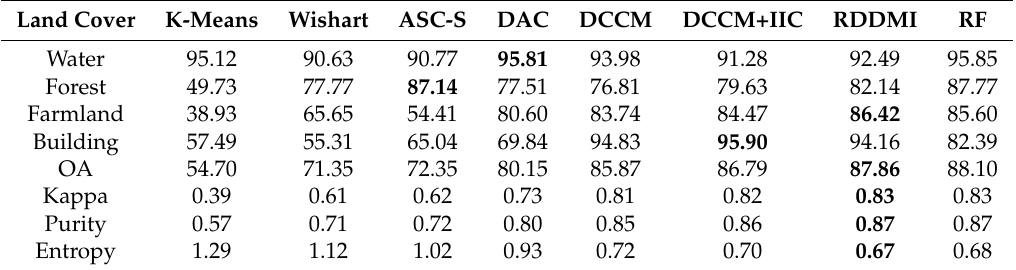
Table 3. Performance evaluation of RS-2 Flevoland classification results. The numbers in bold denote the best unsupervised classification